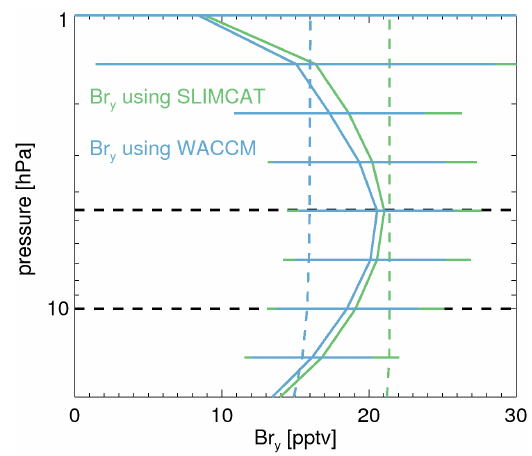
Fig. 12. Average Br y inferred from MLS data using the SLIMCAT (green) and the WACCM (blue) models as described by Eq.( 2). Av- erage is for the year 2005. The error bars reflect a combination of the measurement errors, the systematic errors and the kinetics er- rors. For comparison, the dashed lines show the SLIMCAT (green) and WACCM (blue) modeled values. The region between the black dashed lines indicates where the MLS ascending-descending differ- ence are suitable for scientific use. Fig. 13. Estimates of Br